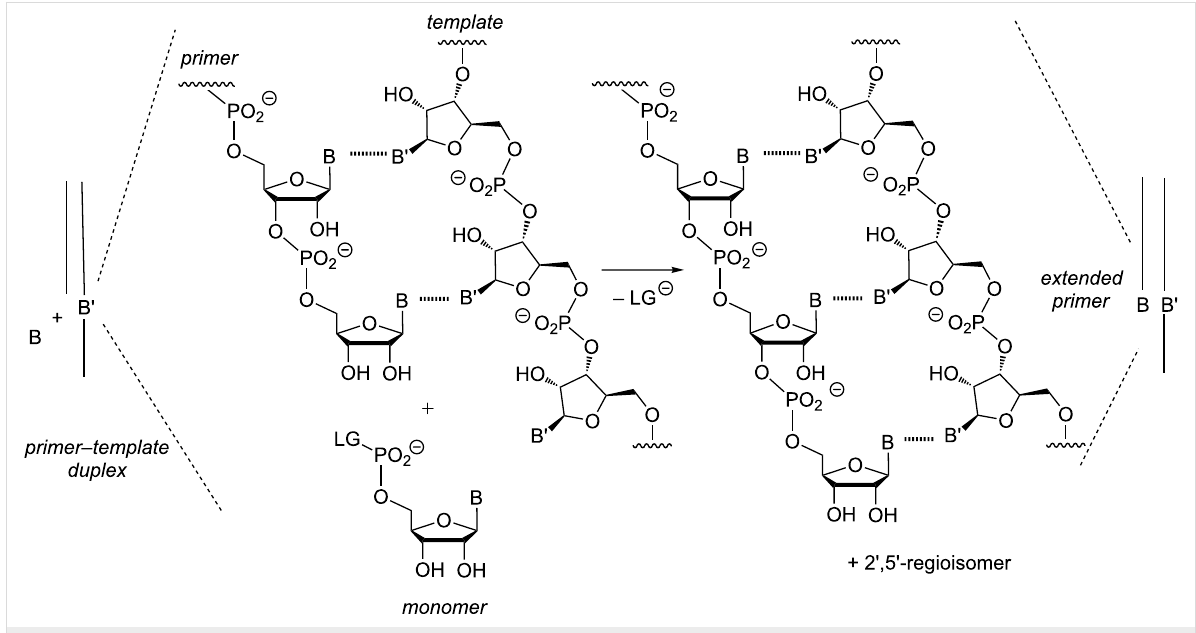
Figure 1: Enzyme-free template-directed extension of an RNA primer by one nucleotide. B = nucleobase, LG = leaving group.